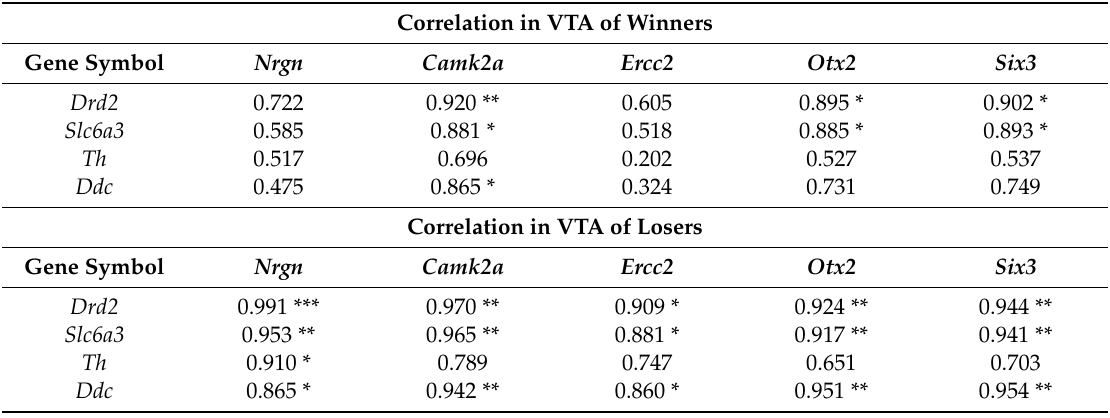
Table 8. Correlation between expression of the key genes ( Nrgn , Camk2a , Ercc2 , Otx2 , and Six3) and genes related to the dopamine signaling